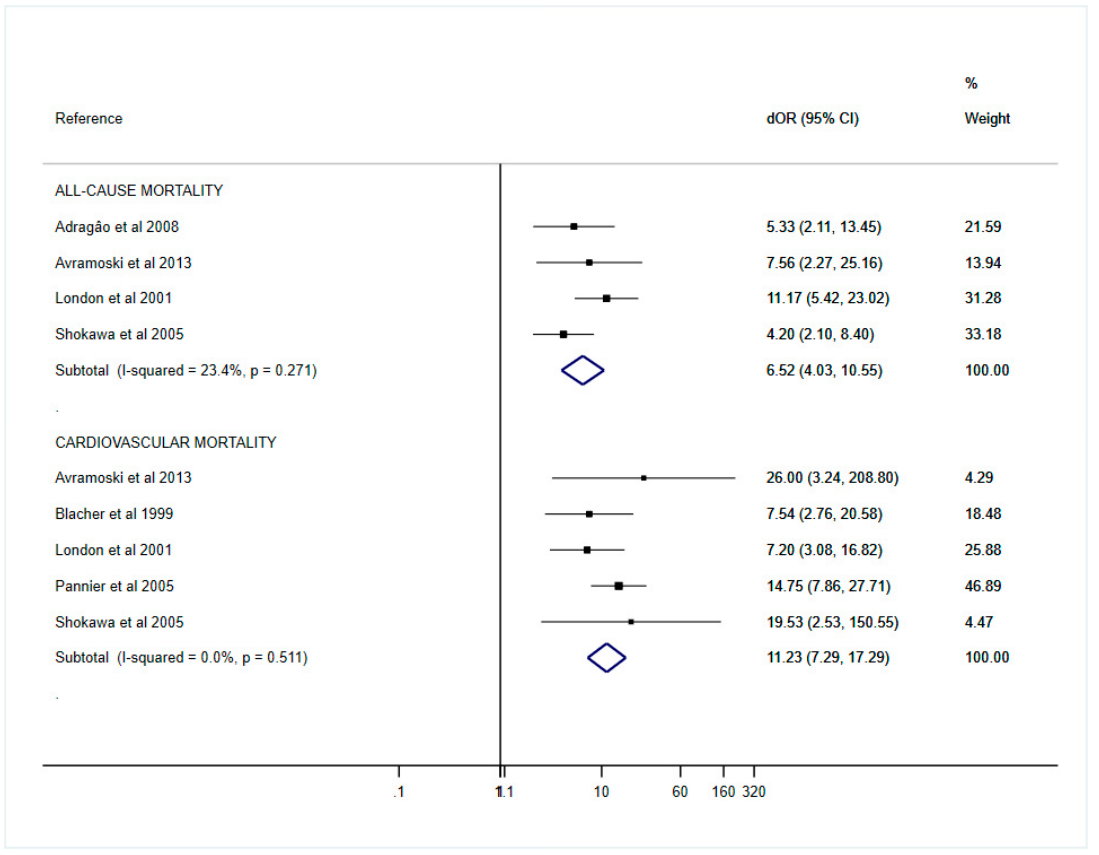
Figure 2. Forest plot of pooled dOR estimates for all-cause and cardiovascular mortality. Table 3. Pooled accuracy parameters in the prediction of mortality